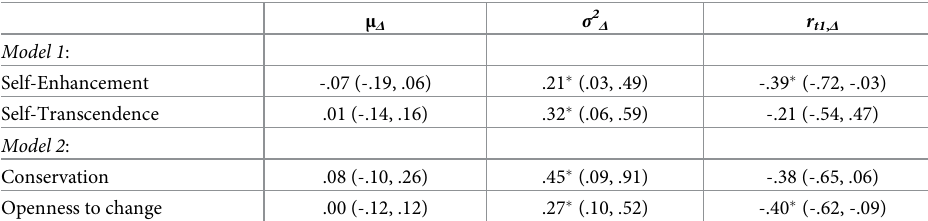
Table 3. Structural parameters of bivariate unconditional LCS models.